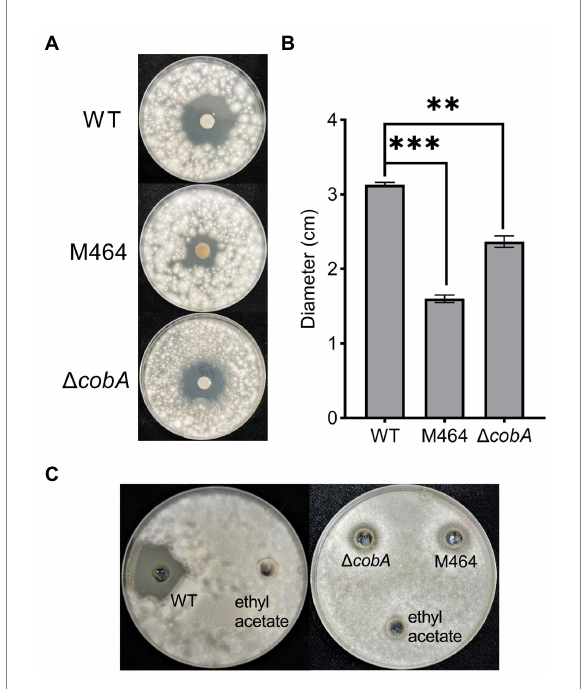
FIGURE 4 The Δ cobA mutant exhibited reduced antifungal activity. (A) Confrontation plate experiment of the antifungal activity of Burkholderia arboris against Fusarium oxysporum . Bacterial solutions (10 μ l at OD 600 of 1.0) from wild type (WT), Δ cobA , and M464 mutant were dropped in the center of the 90 mm PDA plate, and fungi (1.0 × 10 5 spores/ml, 500 μ l) were evenly sprayed on each plate 48 h after the cultivation of B. arboris . Plates were incubated at 28 ° C and images were taken 6 days after the fungal spray. (B) The Δ cobA mutant showed reduced antifungal activity, as evidenced by the small diameter of the inhibition zone. Data are presented mean ± SD ( n = 3). Asterisks indicate significant differences between the wild type and mutants (** p < 0.01, *** p < 0.001, Student’s t -test). The experiments were repeated twice, and similar results were obtained. (C) Crude extract of B. arboris inhibits the growth of F. oxysporum . Crude metabolites were extracted from the wild-type (WT), Δ cobA , and M464 mutants and dissolved in ethyl acetate. The antifungal ability against F . oxysporum was determined on the PDA plates (90